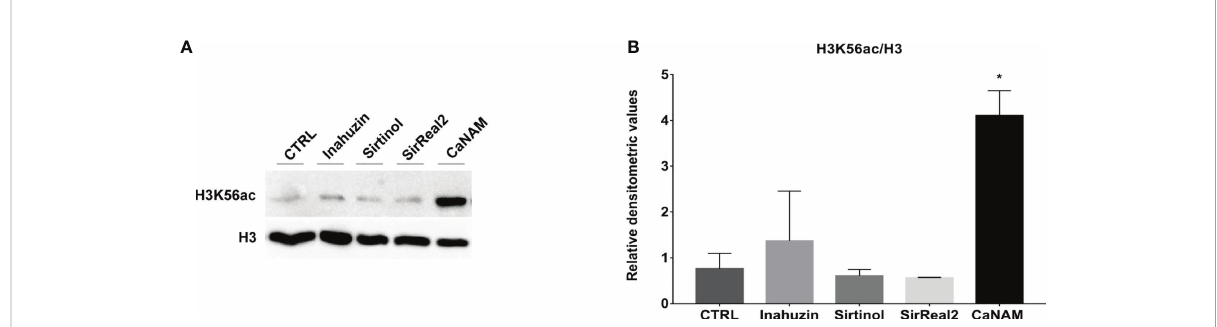
FIGURE 4 Sirtinol, SirReal2, and Inauzhin treatments do not result in H3K56ac accumulation. (A) Candida cells were treated with 50 µM Inauzhin, 10 µM Sirtinol, 50 µM SirReal2 and 10 mM NAM for 16 hours, and H3K56ac was analyzed by Western blotting; (B) Densitometric analysis of H3K56ac normalized to H3 from (A) . Values are mean ± standard error of three independent experiments *p<0.05